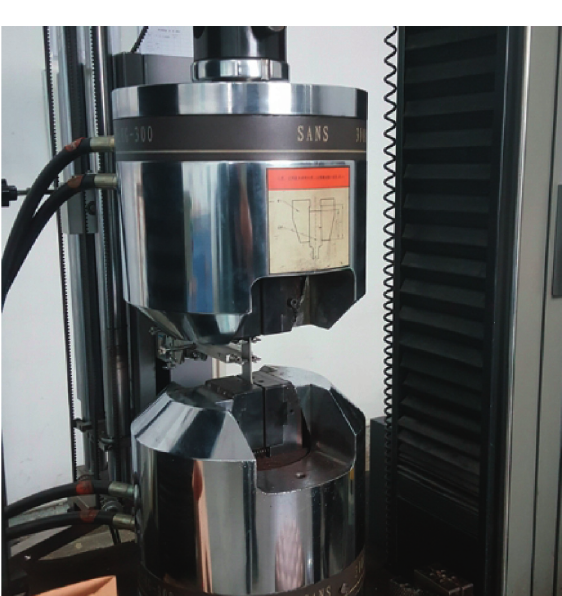
Figure 3: Unidirectional tensile test.